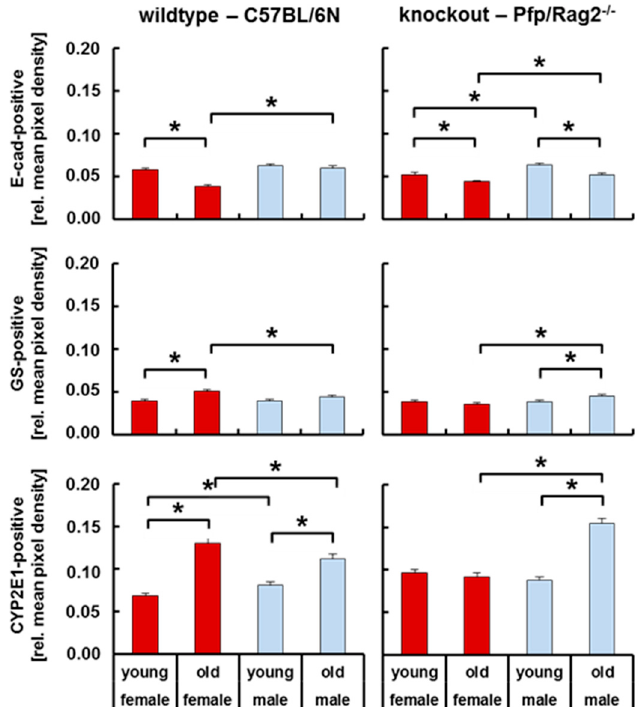
Figure 4. Quantitative expression of periportal E-cadherin (E-cad), and of perivenous glutamine synthase (GS) and Cytochrome P450 2E1 (CYP2E1) in livers from wildtype and knockout female and male mice. E-cadherin, GS, and CYP2E1 abundances were quantified by image analysis of immunofluorescent co-stained E-cadherin and GS as well as E-cadherin and CYP2E1 (Figure S2). The left panels show data from wildtype female (red, bold) and male (blue, light) mice, and the right panels from knockout female (red, bold) and male (blue, light) mice. Horizontal lines marked with an asterisk indicate significant differences at the p ≤ 0.05 level.